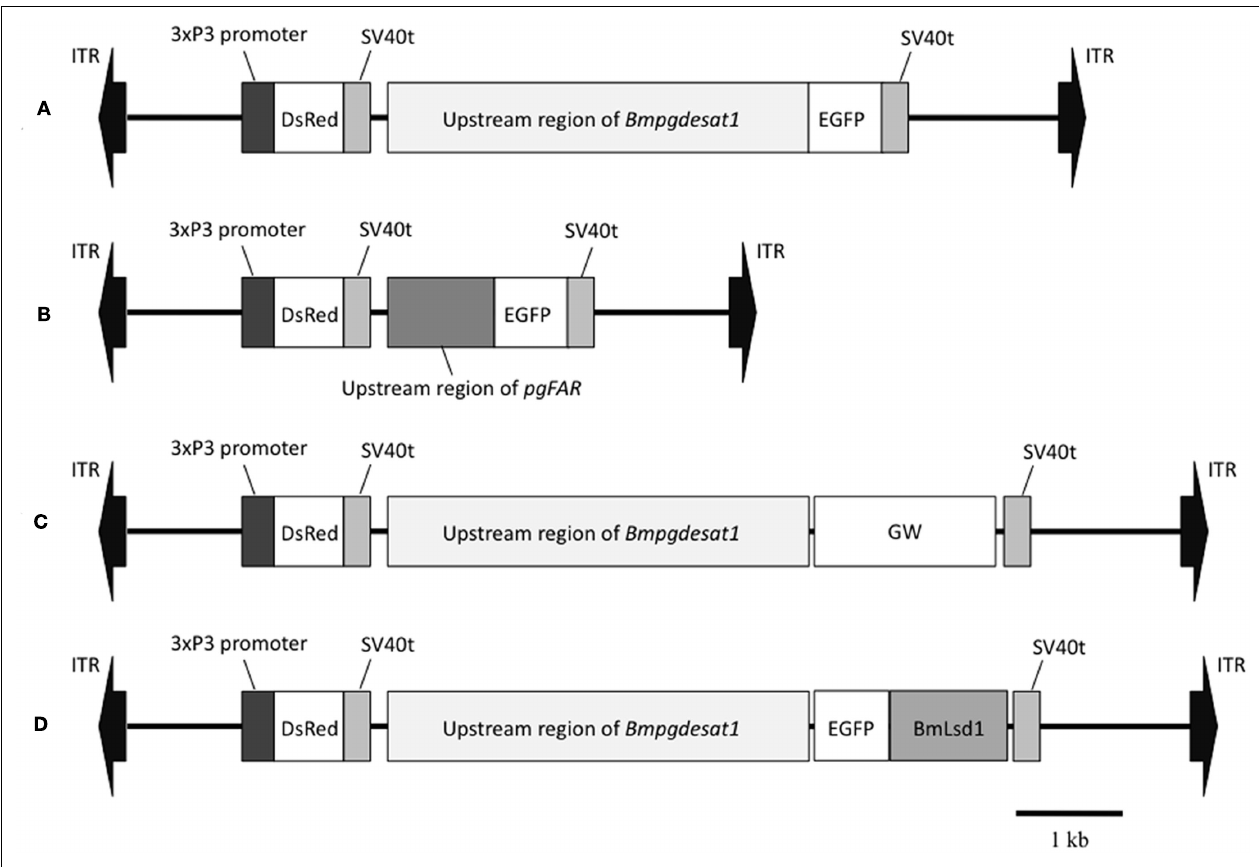
FIGURE 2 | Schematic representation of the piggyBac vectors used in this study. (A) pBac/3xP3-DsRed2/Ds1USR-EGFP. (B) pBac/3xP3-DsRed2/ pgFARUSR-EGFP. (C) pBac/3xP3-DsRed2/Ds1USR-GW. (D) pBac/3xP3-DsRed2/Ds1USR-EGFP-BmLsd1. ITR, inverted terminal repeat of piggyBac transposon; DsRed, Discosoma red fluorescent protein; EGFP, enhanced green fluorescence protein coding region; SV40t, simian virus 40 terminator; GW, gateway recombination